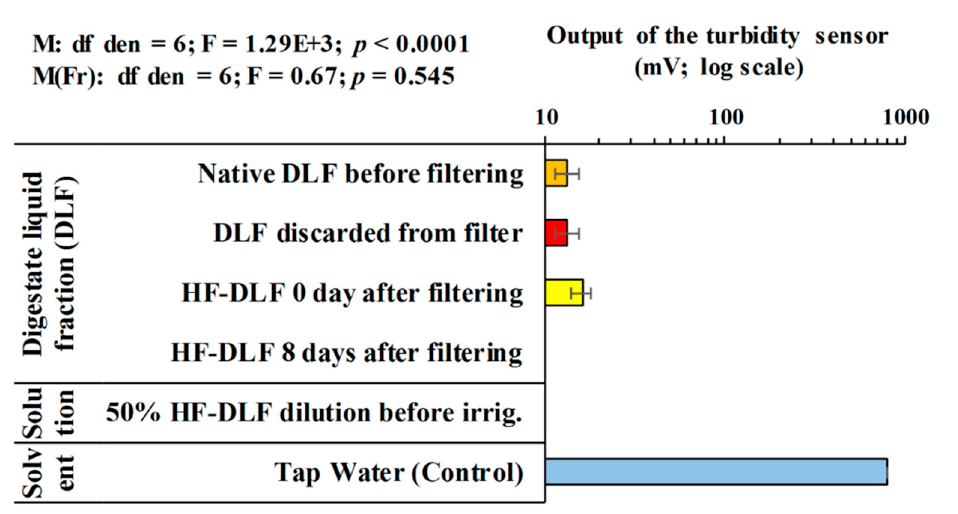
Figure 3. Output of the turbidity sensor in the digestate liquid fraction (DLF), before and after hydrocyclone filtering (HF), the 50% dilution of the HF-DLF, and the tap water used for the experiment. Bars are LSmeans ± Lsmeans standard error estimates. Bars with a letter in common cannot be considered different according to a conservative Tukey-grouping applied to the p - differences of the LSmeans. Results of the statistical analysis are embedded.